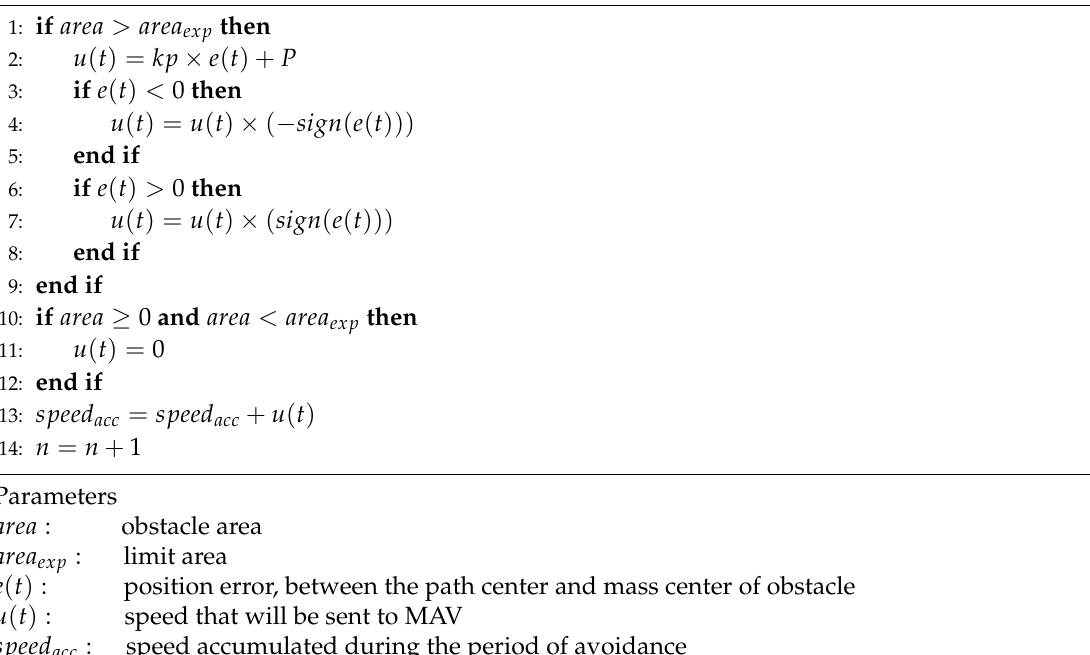
Algorithm 1 Obstacle avoidance algorithm.